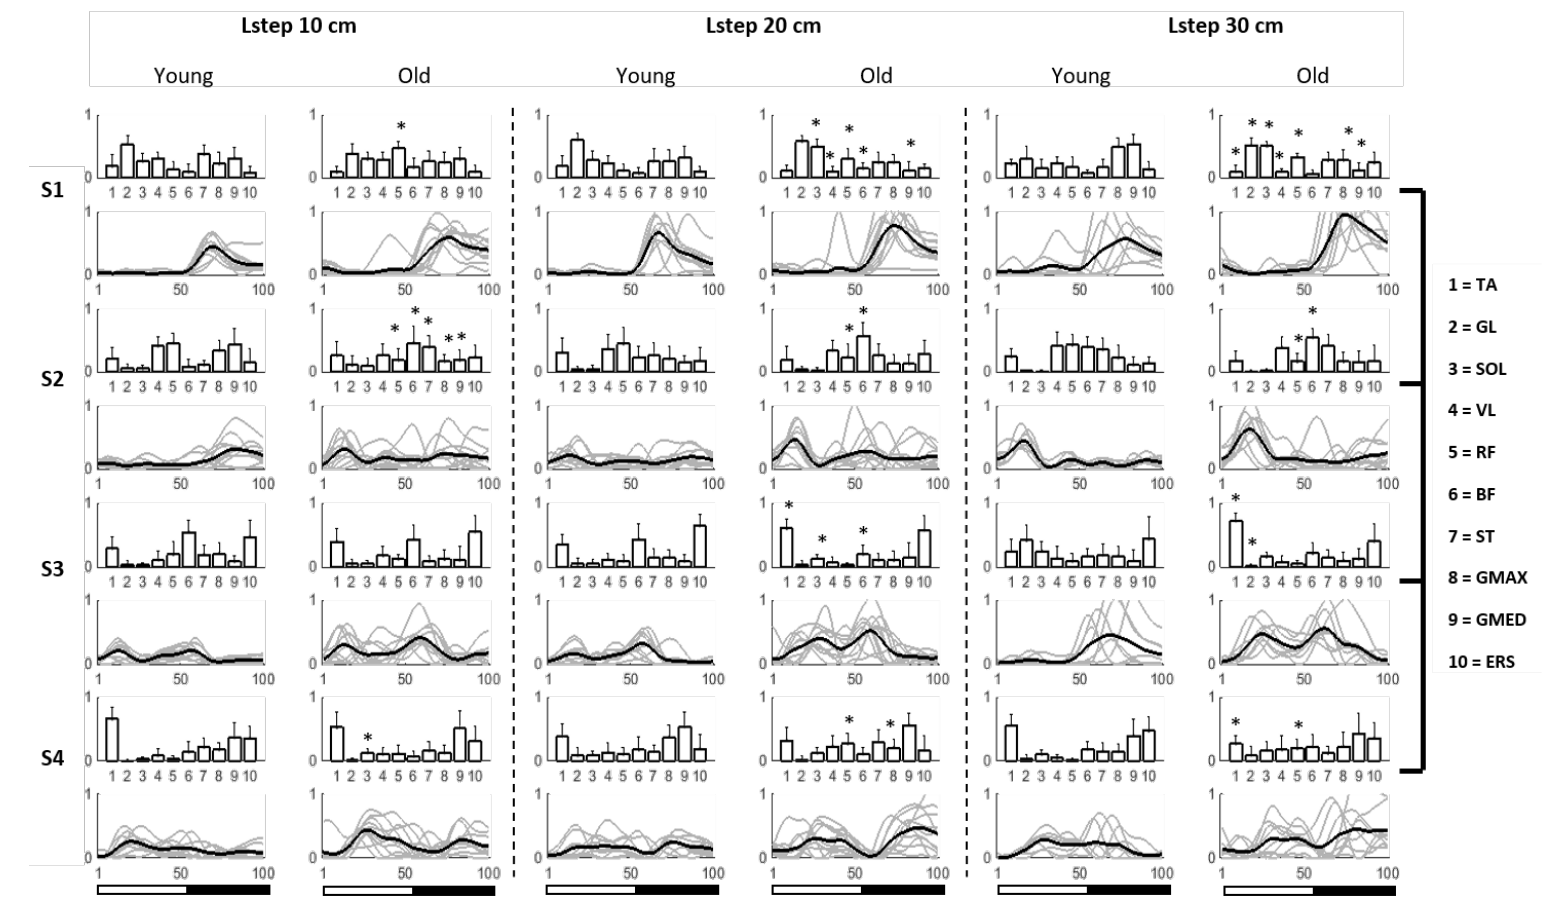
Figure 4. Muscle weightings and temporal activation patterns for four synergies ( S1 – S4 ) extracted during lateral stepping (Lstep). Each set of two columns represents muscle synergies extracted from step heights of 10, 20 or 30 cm per age group with young women represented in the left column and older women in the right column. * indicates a significant di ff erence between contributions of individual muscles between age groups. Time-averaged foot clearance (white bars) and pull-up (black bars) phases of ascent are depicted at the bottom. TA = tibialis anterior, GL = gastrocnemius lateralis, SOL = soleus, VL = vastus lateralis, RF = rectus femoris, BF = biceps femoris, ST = semitendinosus, GMAX = gluteus maximus, GMED = gluteus medius, ERS = erector